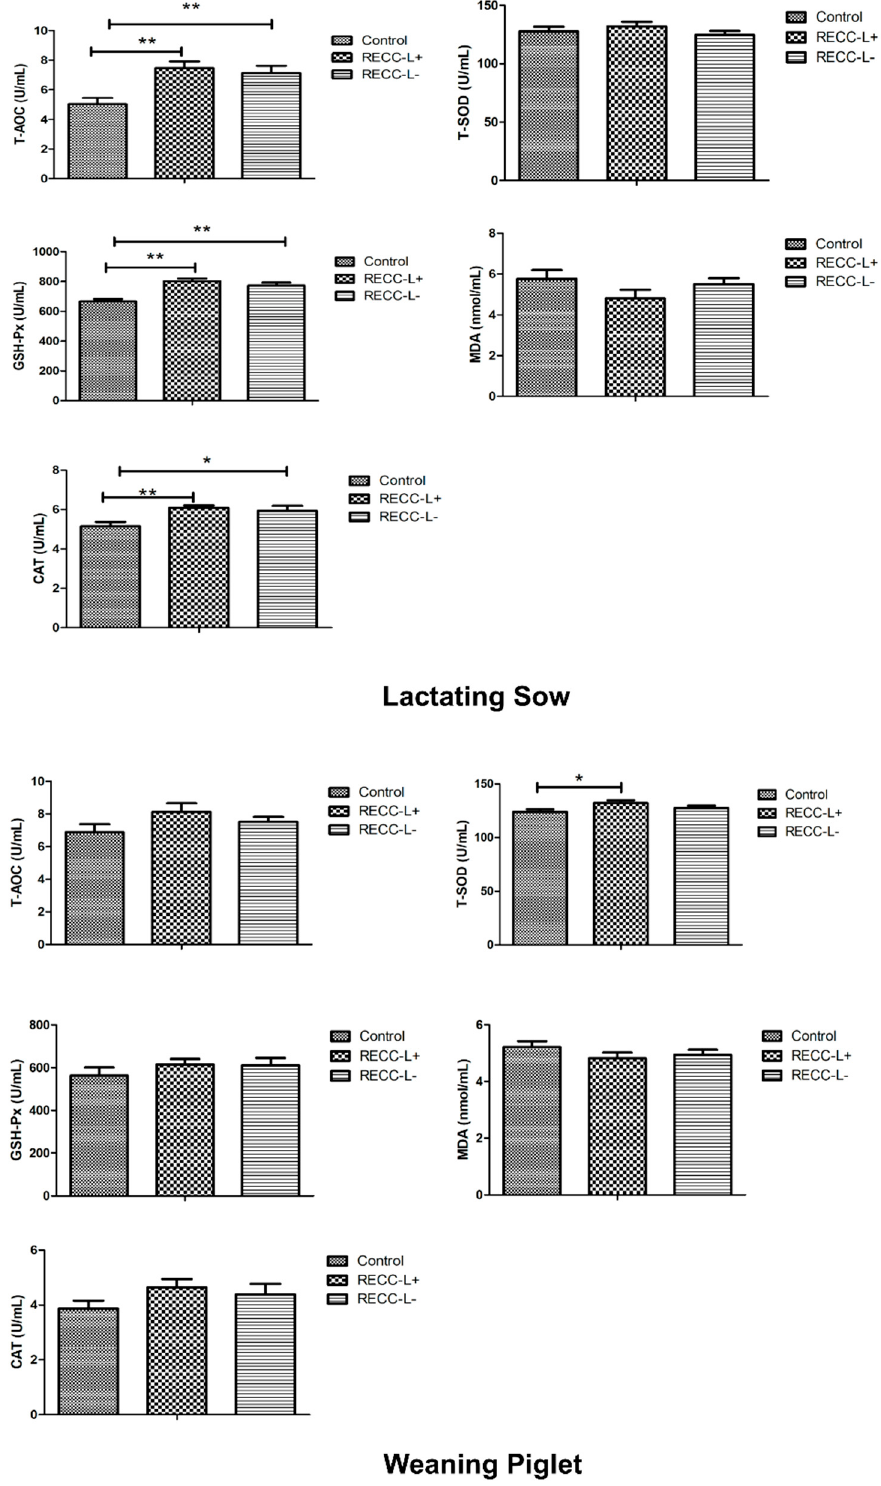
Figure 2. Effect of maternal REE supplementation on plasma antioxidant defense system of the sows and their piglets. n = 8 per group. Values are mean ± SEM. * p < 0.05, ** p < 0.01. REE-L+, REE supplied during gestation and lactation. REE-L-, REE supplied only in late gestation. (Please replace with a sharper image. (Minimum 1000 pixels width/height, or a resolution of 300 dpi or higher). 3.3. Effect of REE Supplementation on Inflammation-Related Indicators in the Sows and Their Offspring